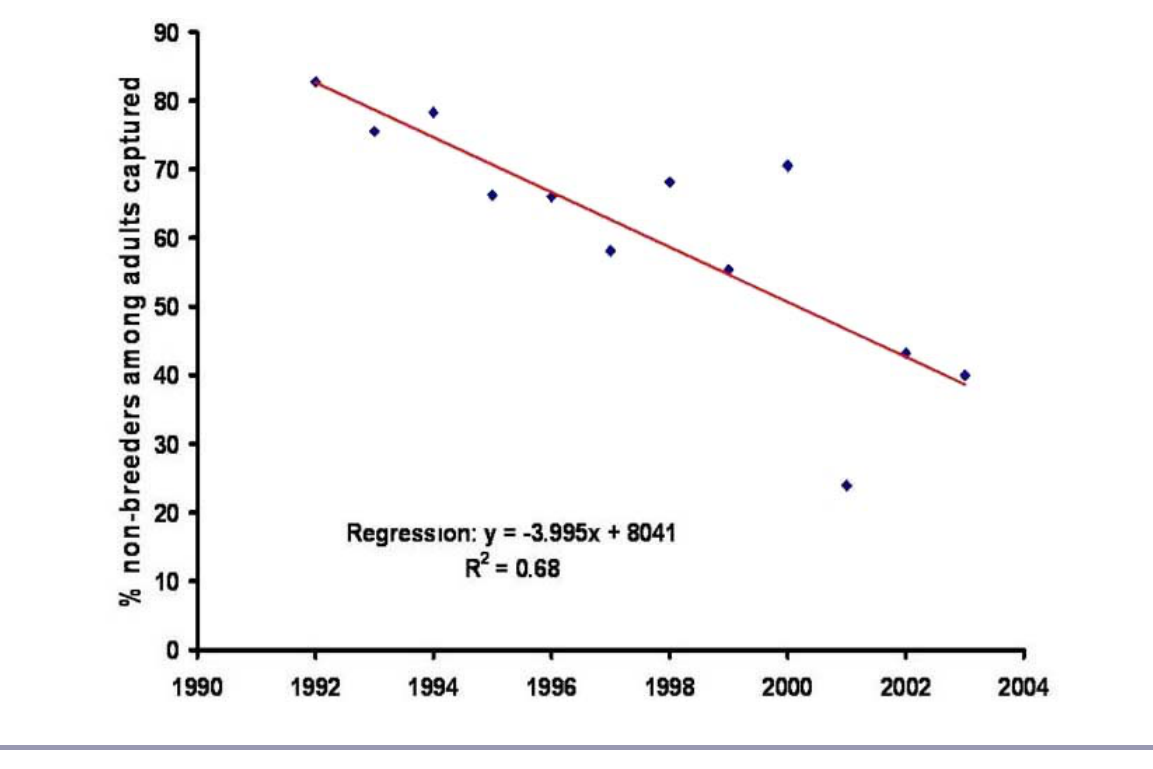
Fig. 4. Proportion of nonbreeders among adult Ancient Murrelets ( Synthliboramphus antiquus ) trapped on East Limestone Island after 02.30 h from 15 May – 15 June during